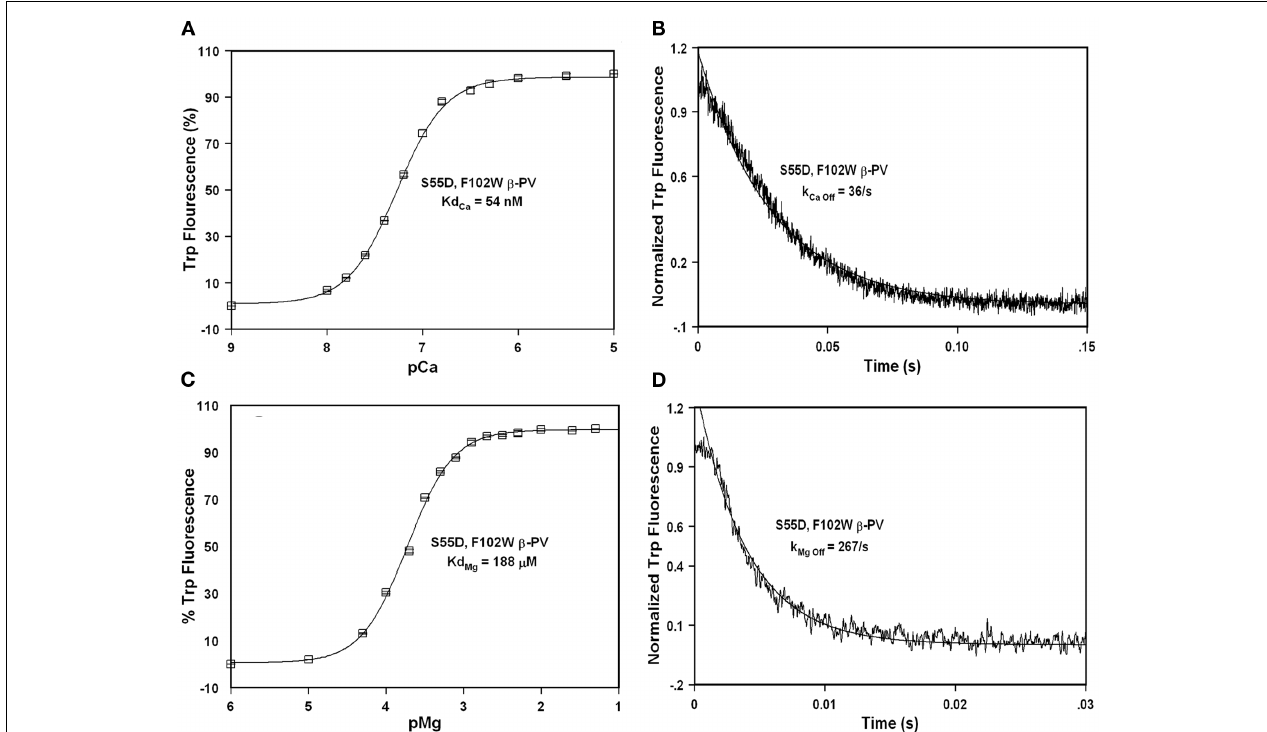
FIGURE 4 | Ca 2 + and Mg 2 + binding and dissociation from S55D, F102W β -PV. (A) The Ca 2 + dependent increase inTrp fluorescence is shown as a function of − Log[Ca 2 + ] (pCa) for S55D, F102W β -PV. (B) The time course ofTrp fluorescence is shown as EDTA rapidly chelates Ca 2 + causing dissociation of Ca 2 + from S55D, F102W β -PV. (C) The Mg 2 + dependent increase inTrp